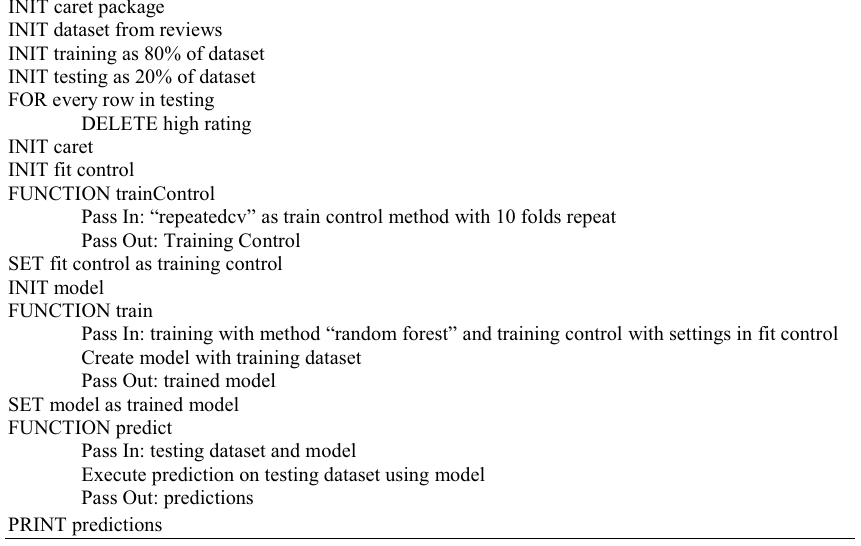
Table 10 Pseudocode to train, test and execute prediction based on model trained INIT caret package INIT dataset from reviews INIT training as 80% of dataset INIT testing as 20% of